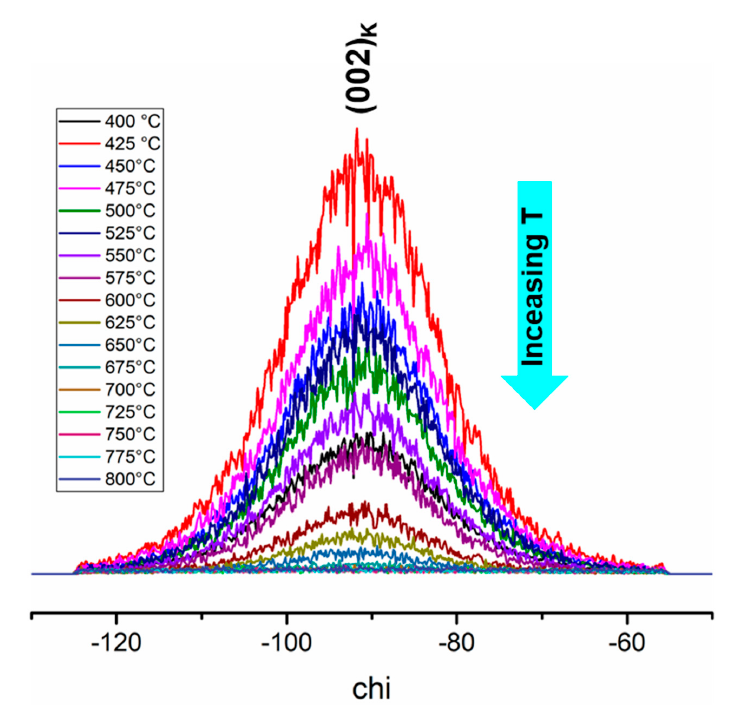
Figure 10. The evolution of intensity as function of chi angle and temperature during the dehydroxylation of Krg100 .